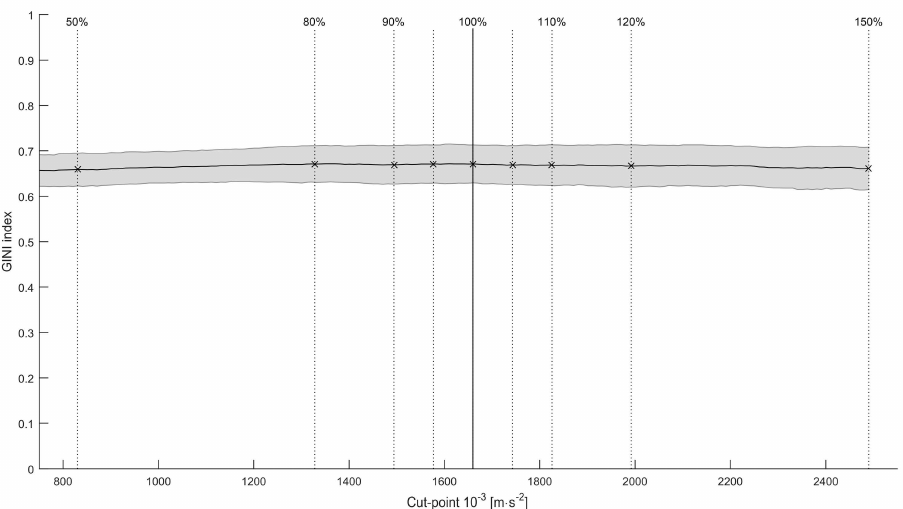
Figure 5. Mean Gini index for various cut-points. The shaded area is the standard deviation. Vertical lines indicate the various thresholds, with the solid line being the optimal